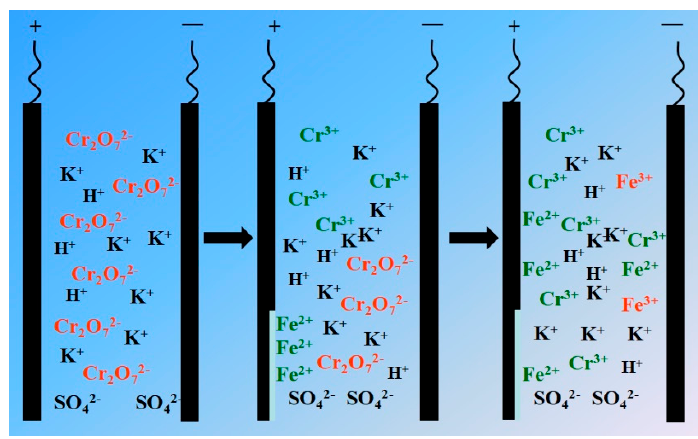
Figure 1. The reaction model for the electro ‐ reduction process.